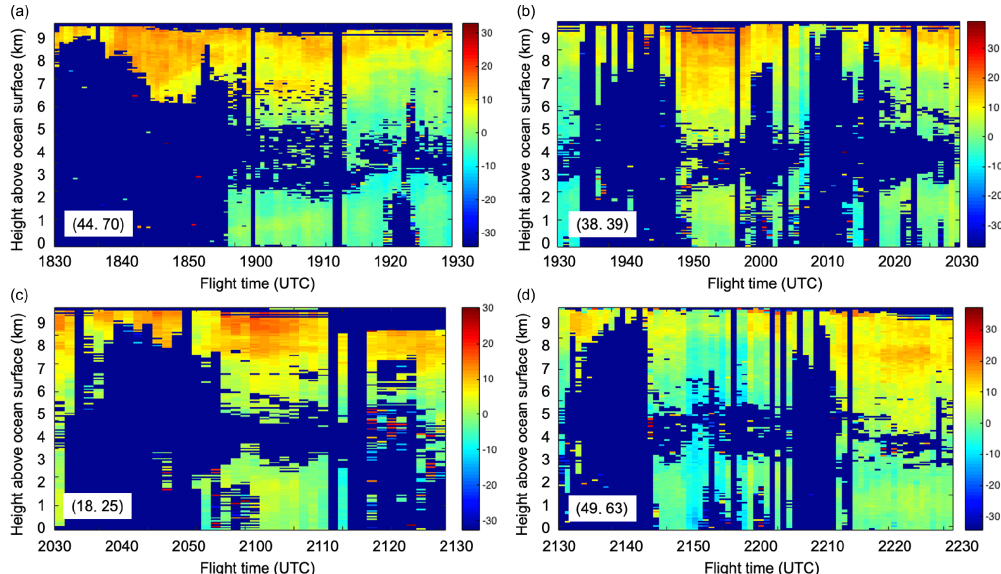
Figure 2. Vertical cross section of the zonal ( u ) component of the DAWN wind profiles preprocessed to ( u,v ) for the 10 June 2017 NU-WRF model impact study. In all panels, the x axis represents 1h of DC-8 flight time, and the y axis extends from the ocean surface to ∼ 9km of height. (a, b) 19:00 and 20:00UTC data assimilation interval. (c, d) 21:00 and 22:00UTC interval. The two numbers in parentheses indicate the number of DAWN wind vectors at 2 and 8km of height, respectively.